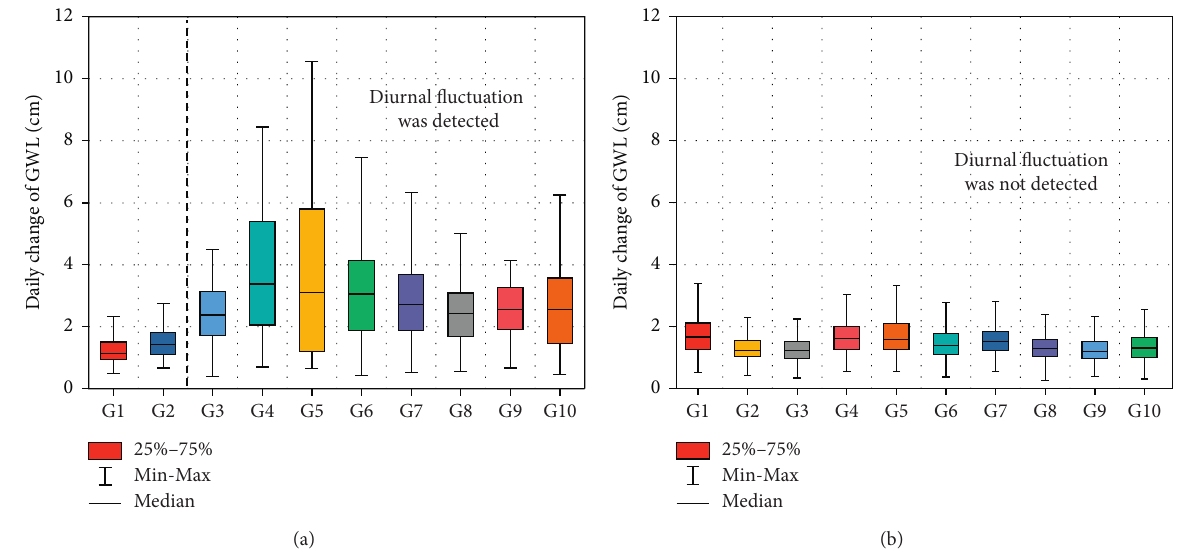
Figure 4: Comparison of boxplots of the amplitude in groundwater level (GWL) during the (a) growing season and (b) nongrowing season. The vertical dashed line in (a) separates sites with no regular diurnal GWL fluctuations (G1 and G2) and those with fluctuations (G3–G10); no fluctuations were detected in